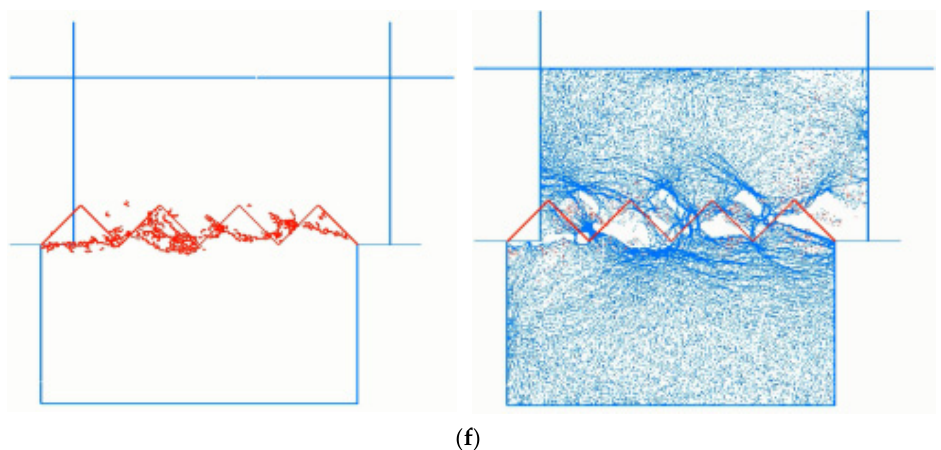
Figure 5. Distribution of cracks expansion and contact force with different shearing displacement. ( a ) Shear displacement = 1 mm. ( b ) Shear displacement = 2 mm. ( c ) Shear displacement = 3 mm. ( d ) Shear displacement = 4 mm. ( e ) Shear displacement = 5 mm. ( f ) Shear displacement = 10 mm.